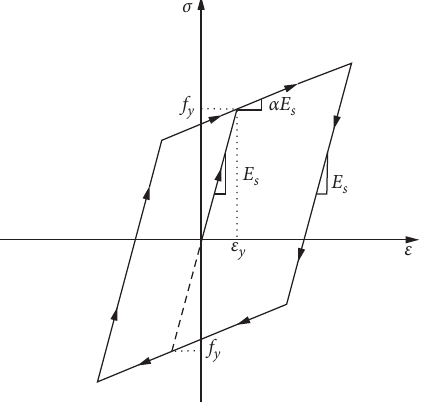
Figure 20: Stress-strain relationship of